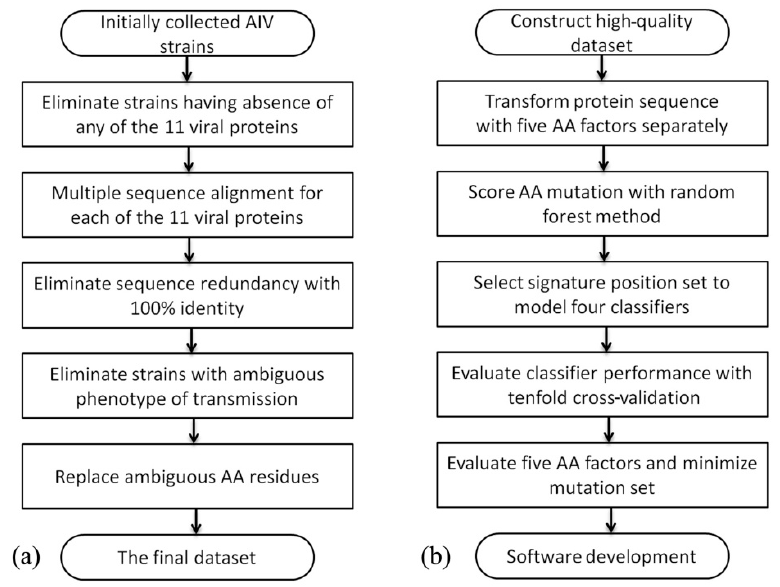
Figure 4. Flowchart of methods used in this paper. ( a ) High-quality dataset construction; ( b ) Machine learning algorism.